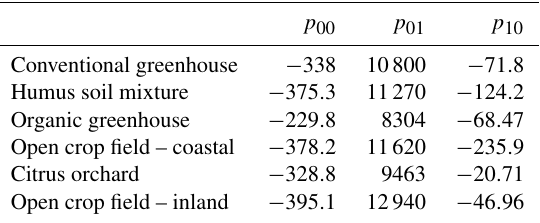
Table 3. Calibration coefficients for the multivariate regression model of the study site’s obtained water